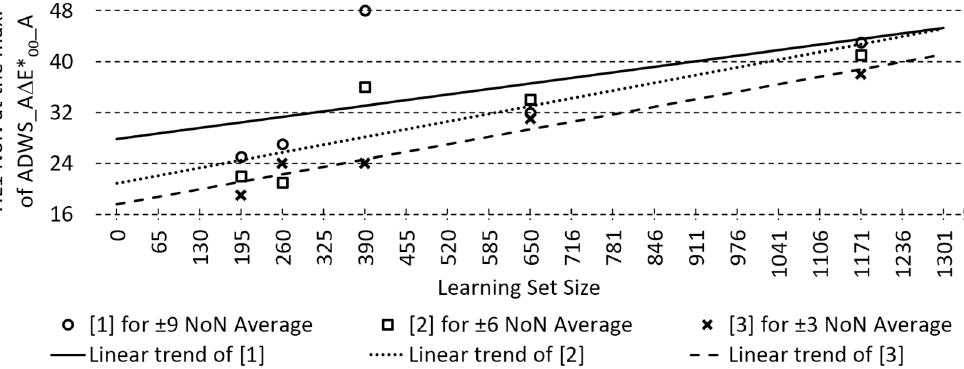
Figure 12. Number of neurons in the 1st hidden layer (HL1 NoN) at the max. of Averaged Differences between “slight”–”noticeable” perception margin and the Weighted Sum of Average CIEDE2000 colour differences with illuminant A (ADWS_A ∆ E* 00 _A) at the observed learning set sizes and their linear approximations for GH4 camera (C3) according to the different averaging interval widths.